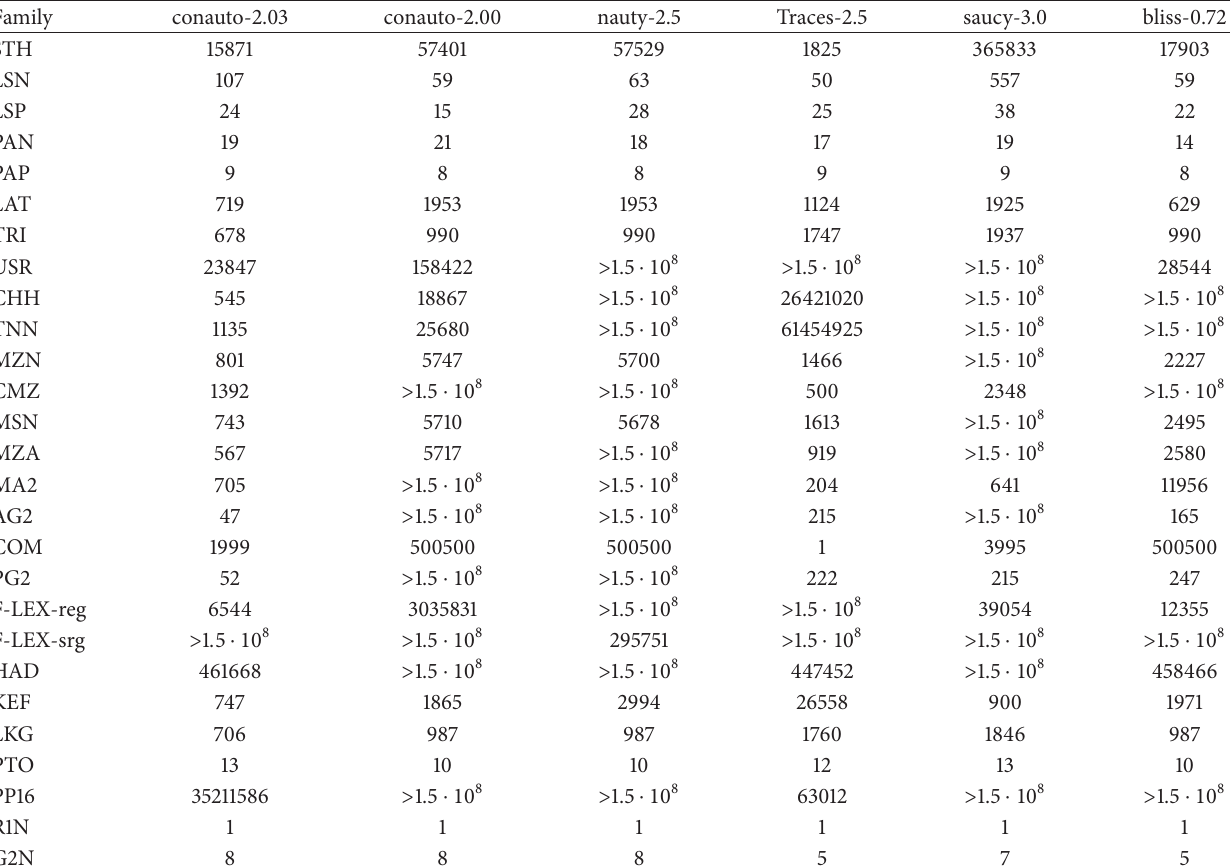
Table 2: Maximum search tree size for each family in the